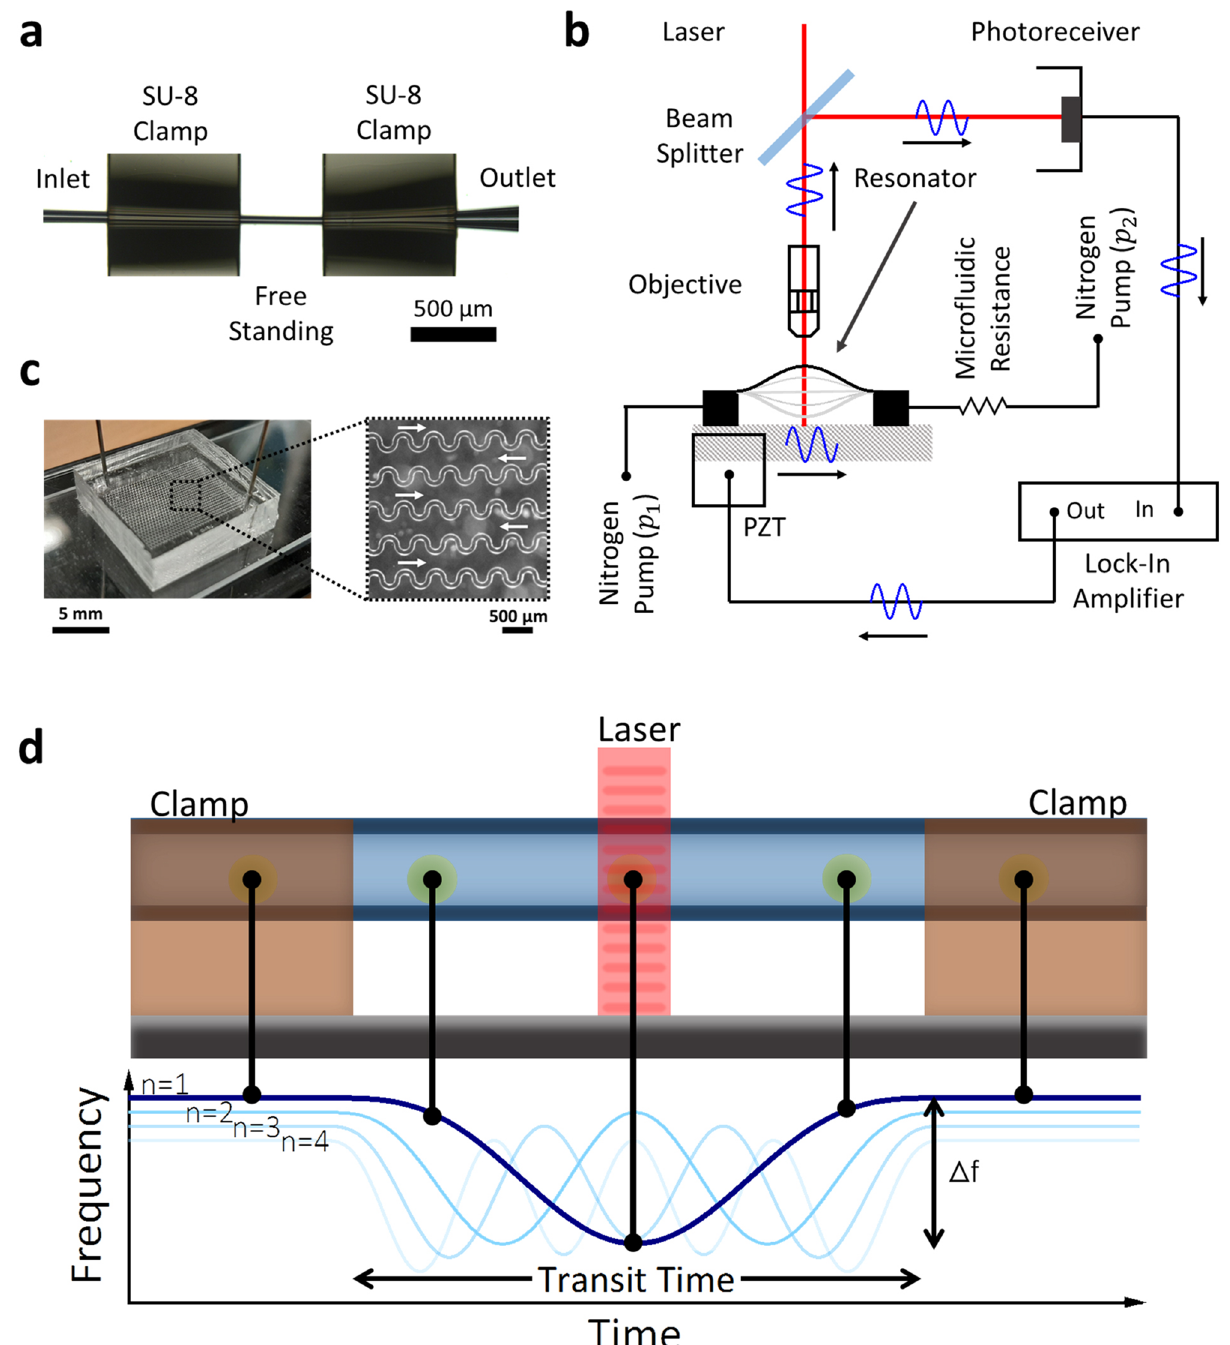
Figure 1. Device characterization. ( a ) Optical micrograph showing a transparent microcapillary resonator. ( b ) Schematics of the experimental setup. The homemade optical interferometric system and details of the microfluidic setup. ( c ) Image of the PDMS microfluidic resistance. White arrows indicate flow direction. ( d ) Working principle of the nanomechanical sensing using transparent microcapillary resonators, showing the frequency shifts that the particle produces for the first four mechanical